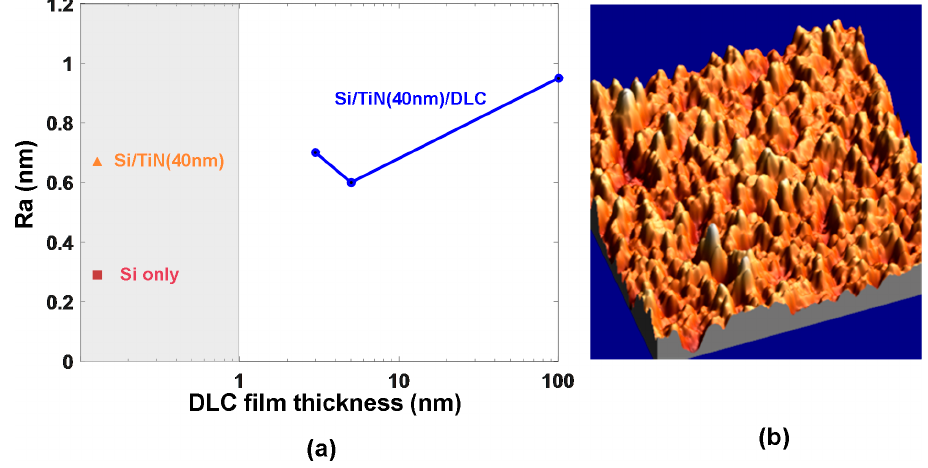
Figure 25. ( a ) Surface roughness obtained for different sample stacks, and ( b ) topographical image of the previously optimized sample stack with 5 nm thick DLC capping film.